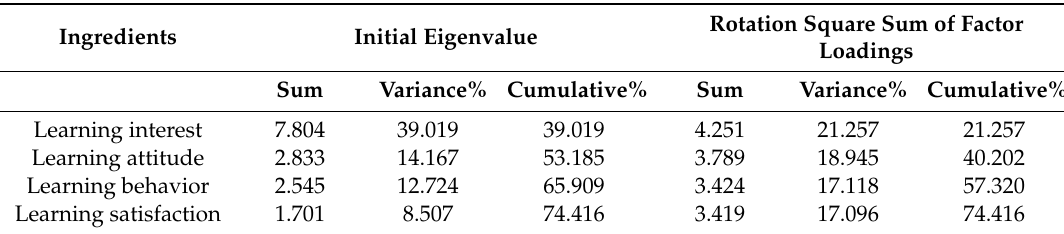
Table 6. Total variance explained by the factor